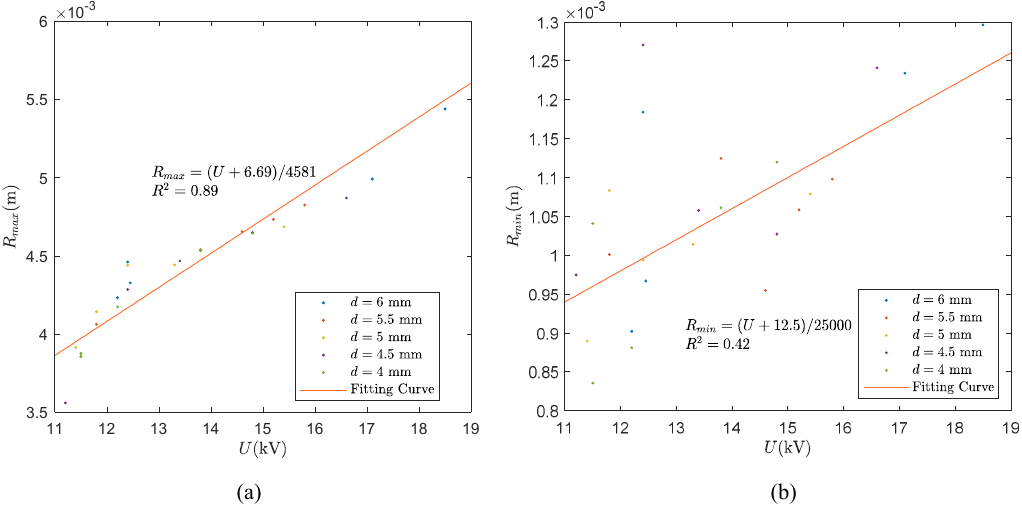
Figure 7. Relationship between breakdown voltage and the radius of cavitation bubbles. (a) The relationship between breakdown voltage and maximum radius of the cavitation bubbles; (b) the relationship between breakdown voltage and minimum radius of the cavitation bubbles.